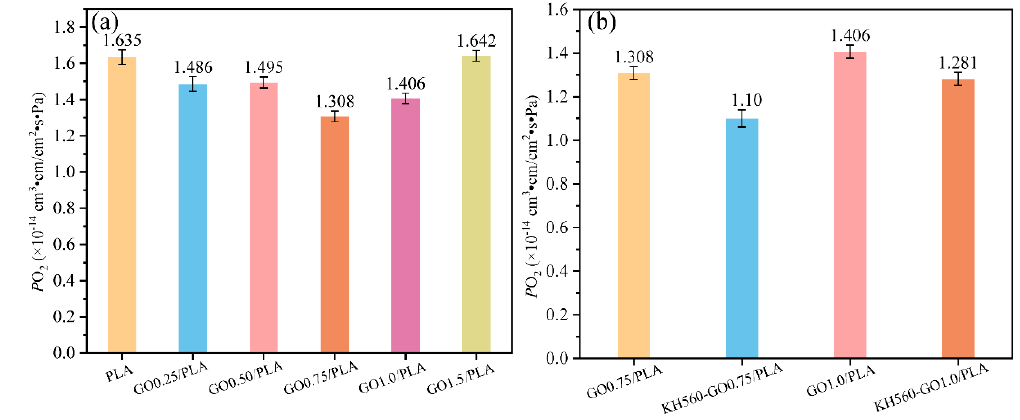
Figure 5. O 2 permeability of ( a ) GO / PLA and ( b ) KH560-GO / PLA samples as a function of GO and KH560-GO content.